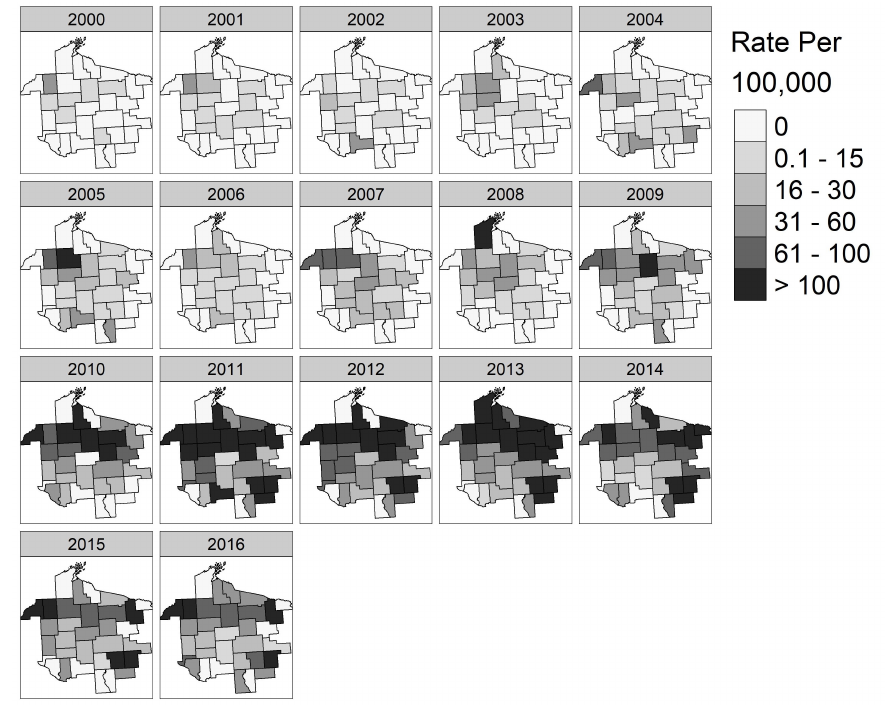
Figure 4. Annual county level incidence rate for positive laboratory cases of combined tick-borne diseases caused by human granulocytic anaplasmosis, babesiosis, ehrlichiosis per 100,000 patients, 2000–2016 for the Marshfield Clinic Health